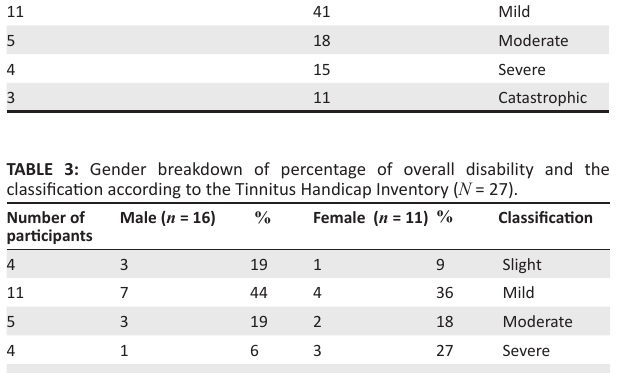
Scores and means obtained from the tinnitus handicap inventory. n , number.